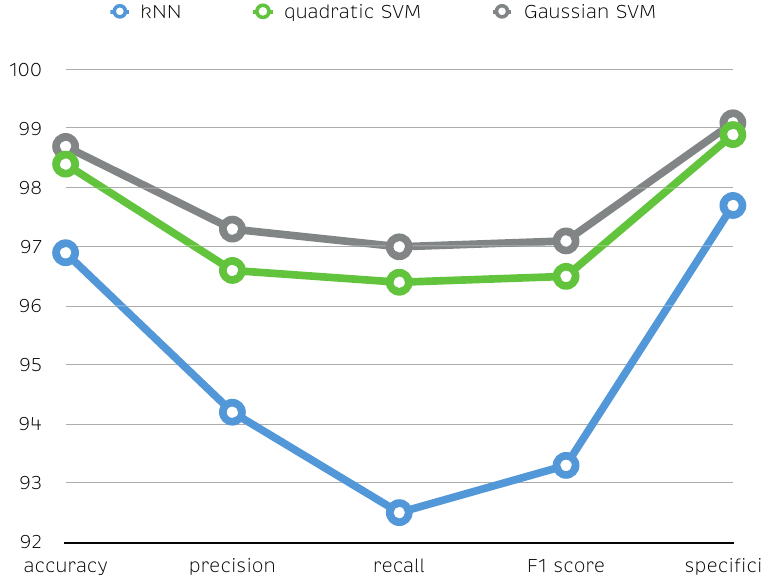
Figure 9. Performance measures (percentage) comparison among the different